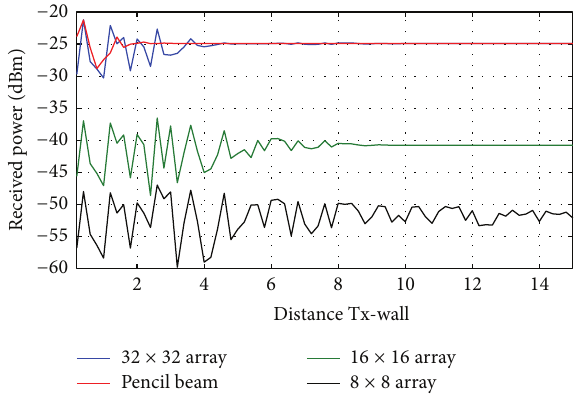
Pencil beam Figure 6: Received power for different wall distances.